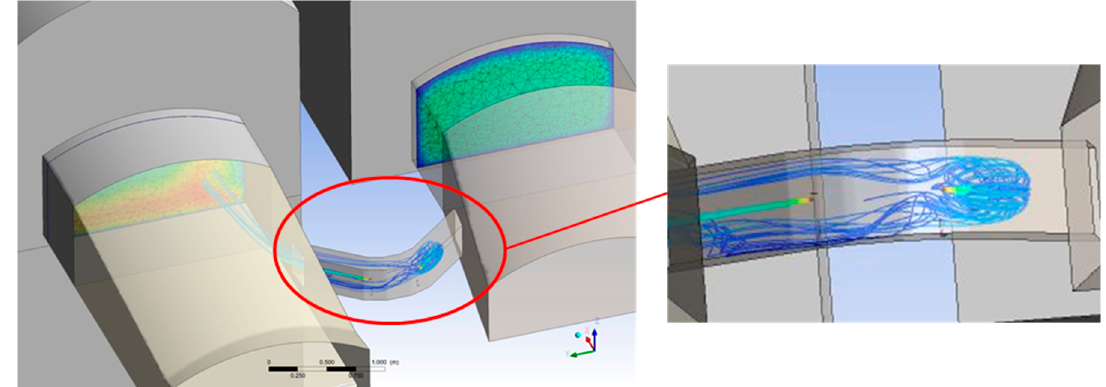
Figure 20. Detail of the flow structure—pros and cons injector flow streamlines.